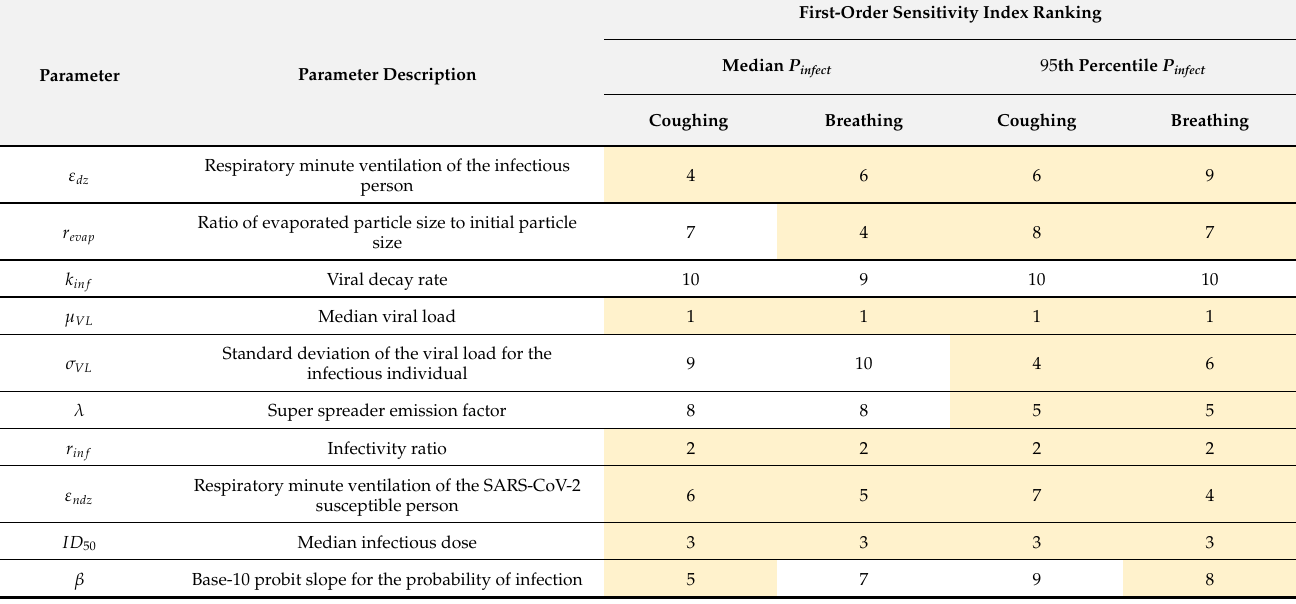
Figure A7. First-order sensitivity indices (ordered from largest to smallest) derived using eFAST for the median P infect and 95th percentile of P infect with coughing as the emission mechanism. Asterisks (*) indicate statistically significant sensitivity indices ( α = 0.01). Table A3. Ranking of the first-order sensitivity indices for the median and 95th percentile P infect with breathing and coughing as the emission mechanisms. Yellow shaded cells indicate parameters that were determined to be statistically